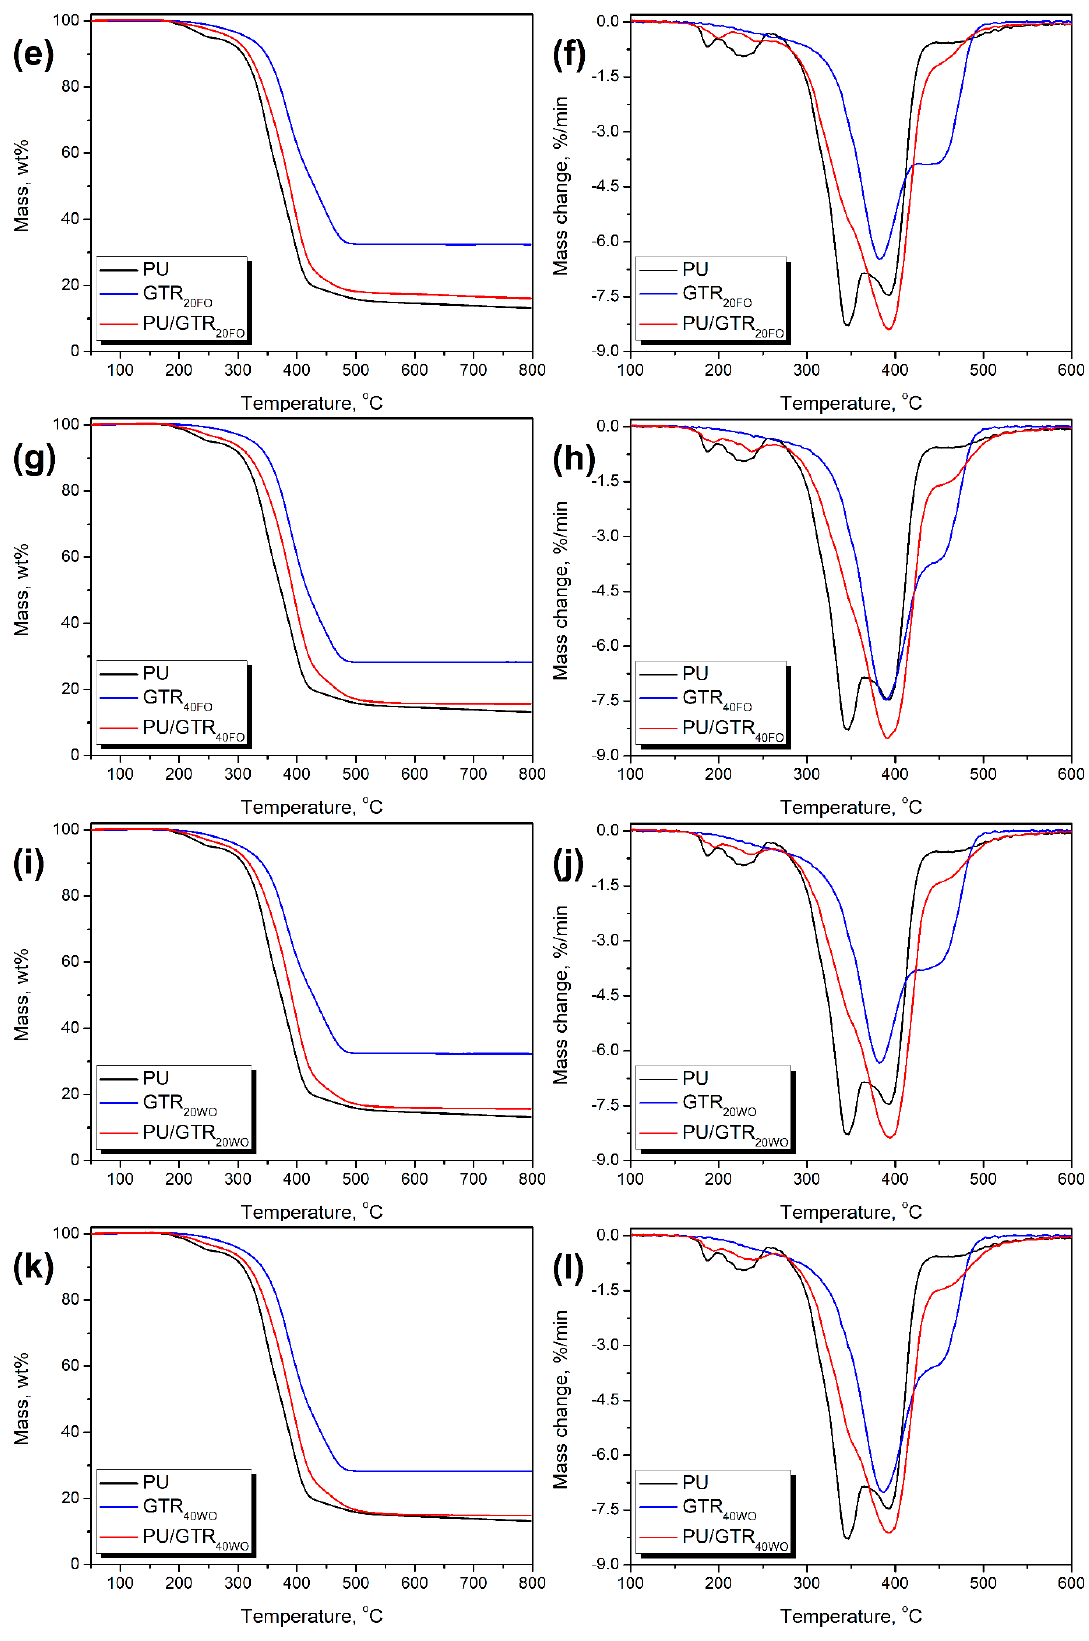
Figure 10. The results of thermogravimetric analysis for of ( a , b ) PU/GTR, ( c , d ) PU/GTR TM , ( e , f ) PU/GTR 20FO , ( g , h ) PU/GTR 40FO , ( i , j ) PU/GTR 20WO , and ( k,l ) PU/GTR 40WO